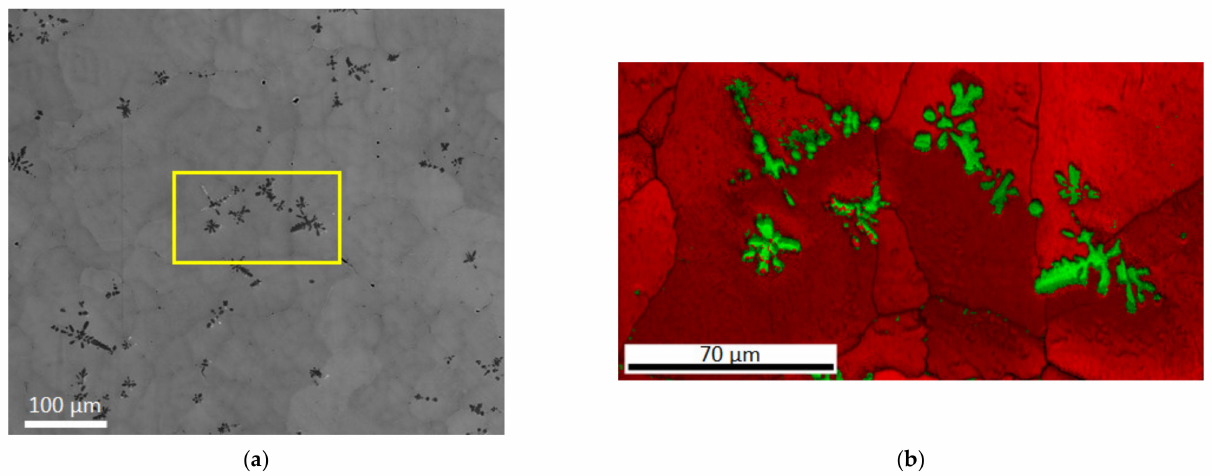
Figure 5. FCC Ti-rich precipitates embedded in the BCC matrix in (TiVNb) 75 Cr 25 multi-principal element alloy. ( a ) Secondary electrons SEM image. The yellow rectangle indicates the EBSD acquisition area. ( b ) EBSD phase map. The red and green areas were indexed respectively as BCC and FCC phase